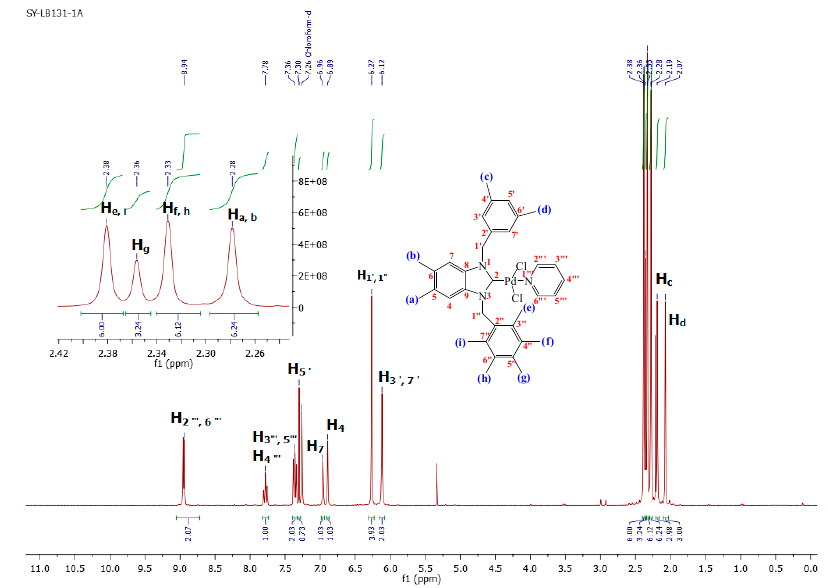
Figure 3. 1 H-NMR spectra of palladium PEPPSI-type complex 3a in CDCl 3 .